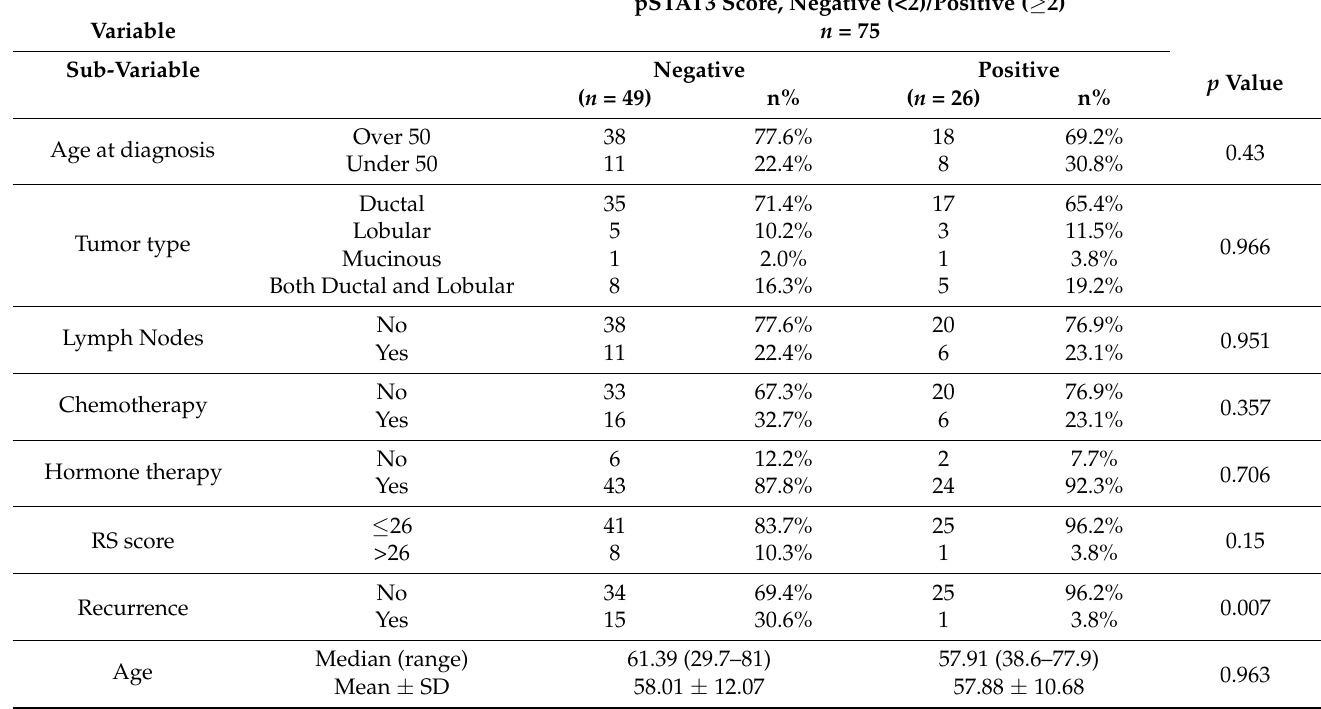
Table 1. Patient characteristics according to pSTAT3